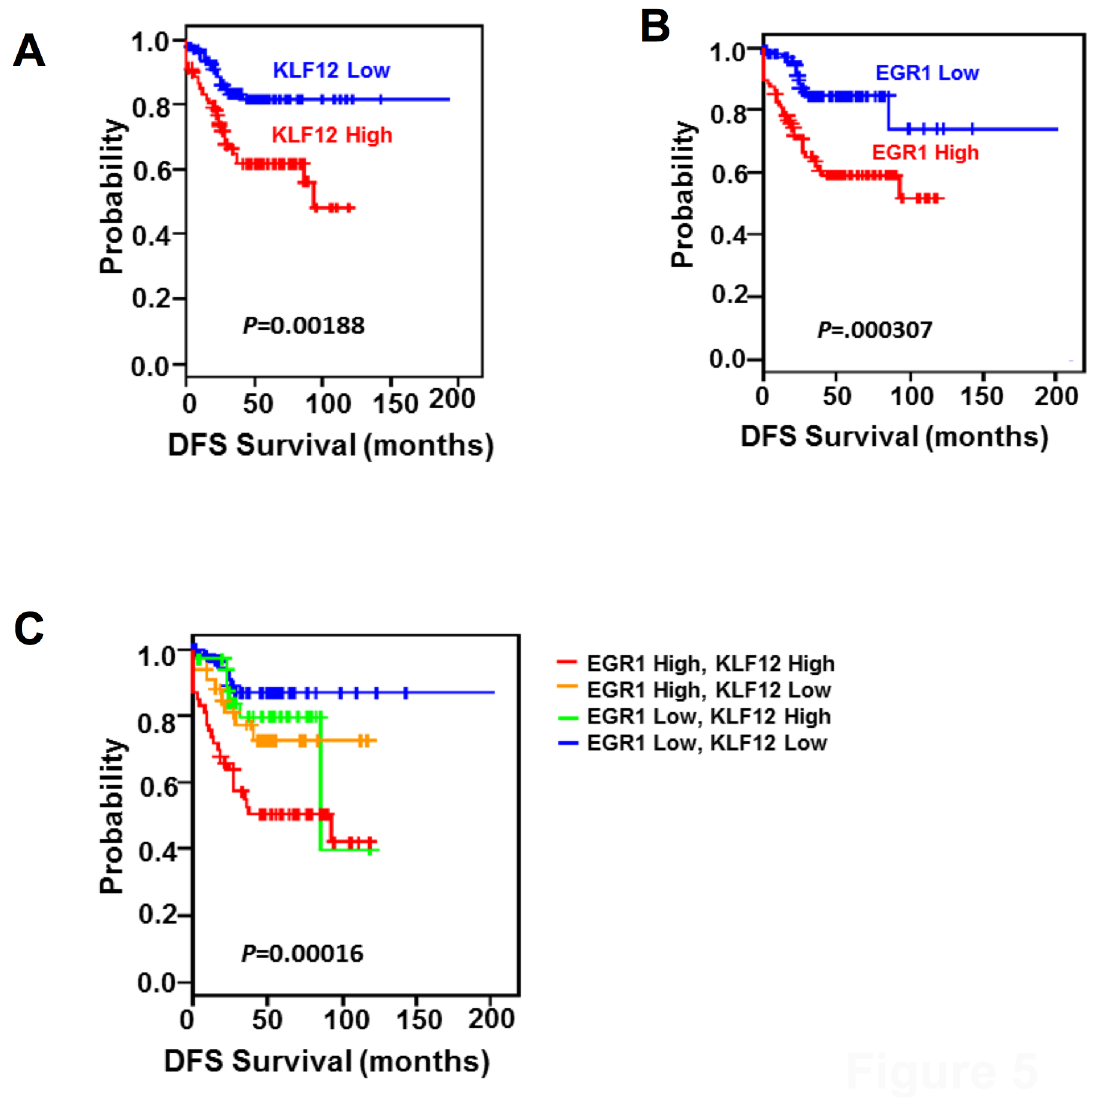
Fig 5. KLF12 and EGR1 expression levels are synergistically correlated with worse prognosis in CRC. Kaplan-Meier Disease free survival (DFS) curves of a cohort of 232 CRC patients (Moffitt cohort, n = 177; Vanderbilt Medical Center cohort, n = 55) with either high or low mRNA levels of KLF12 (A), EGR1 (B), or both (C). Vertical bars denote censored